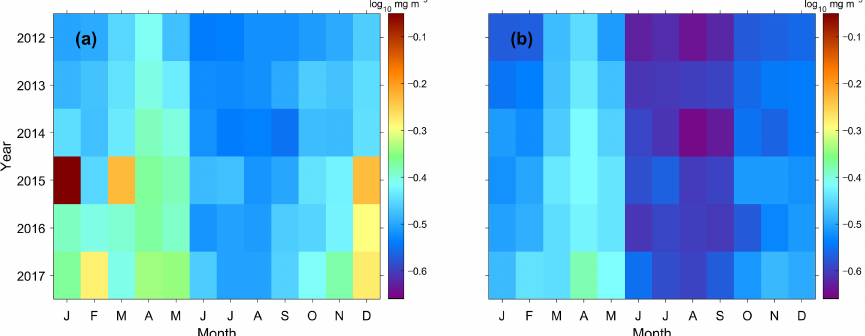
Figure 11. Month-year plot of chlorophyll- a concentration from ( a ) GOCI level-2 data and ( b ) reprocessed data after the speckle-removal process for the period of